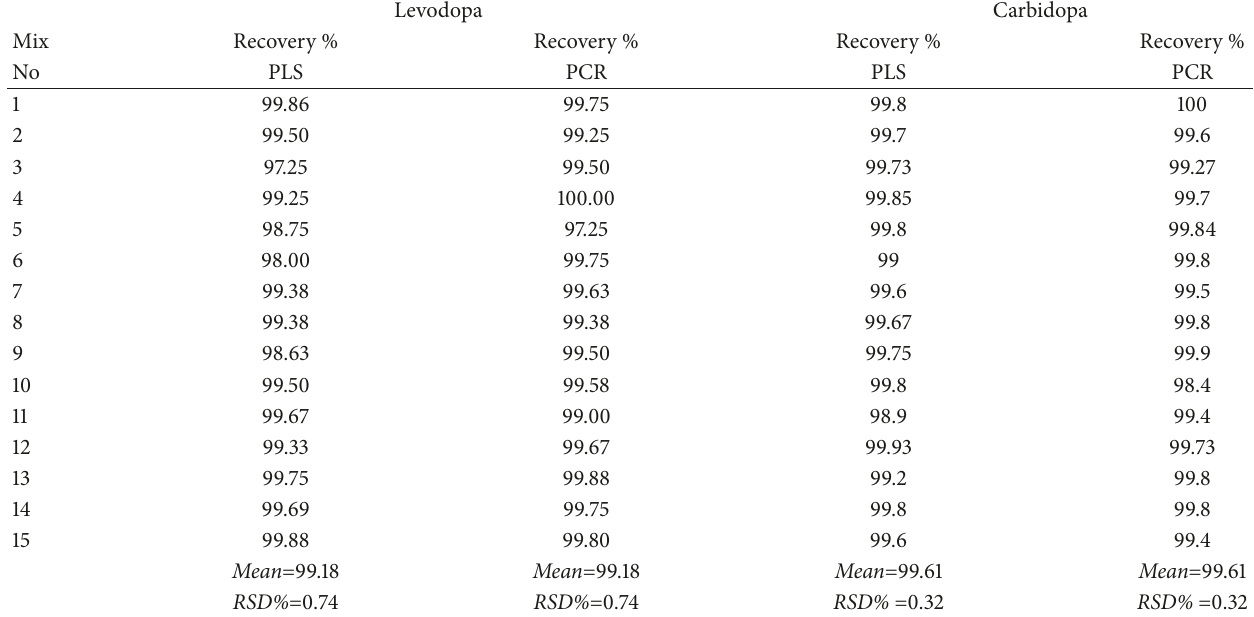
Table 2: Calculated statistical parameters by chemometric methods